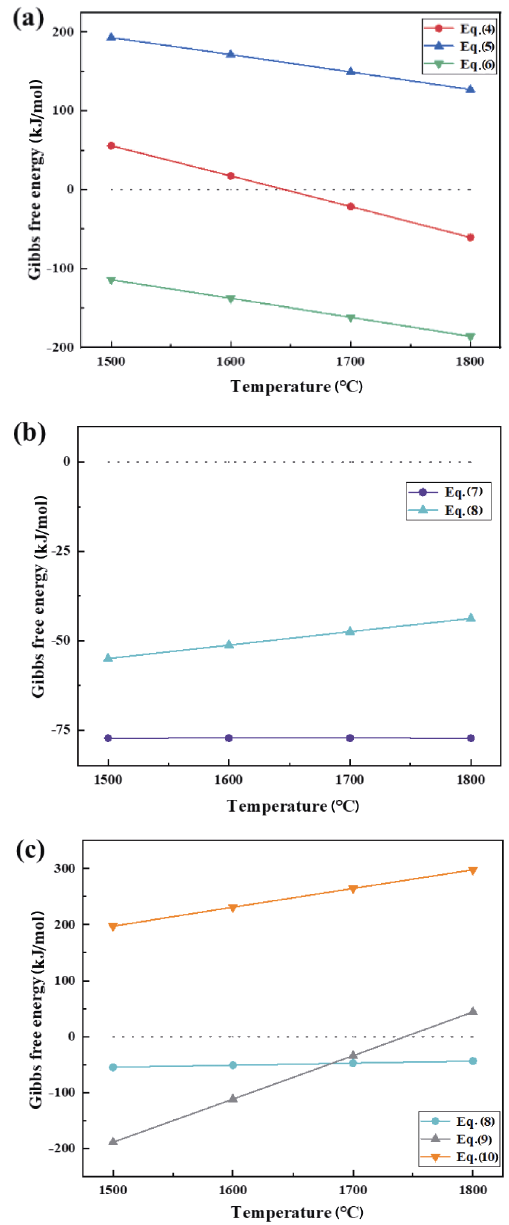
Fig. 5 Gibbs free energy change of Reactions (4)–(10) calculated by FactSage software: (a) formation of intermediate products, (b) formation of SiC nuclei, and (c) growth of SiC w